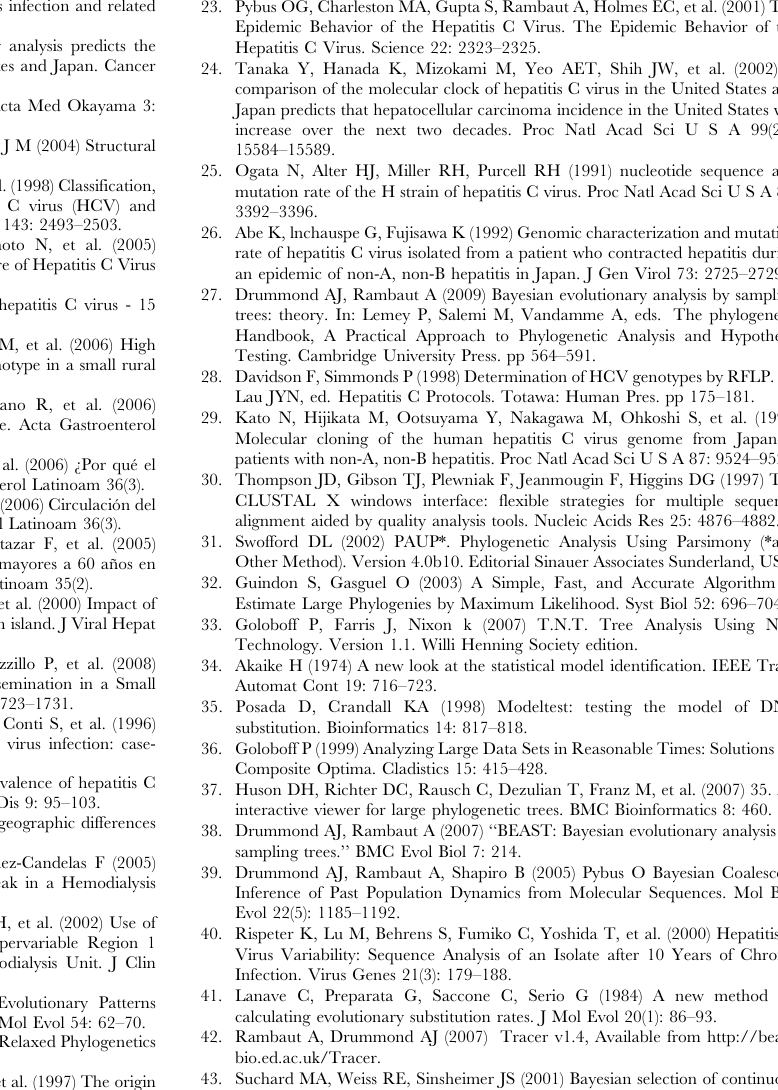
Figure S2 Parsimony phylogeny of the concatenated analysis obtained with the TNT software. The strict consensus tree of parsimony analysis obtained from eight most parsimony trees. A separation between sequences from the outbreak (red branches, n =55) and those from other sequences can be observed in the shaded area to the right of the figure in the strict consensus tree. Genotypes 1b (references sequences, n= 232) are represented by orange branches and the genotypes No-1b are represented by black branches (n= 34). Group of Wheelwright is detailed to the left of the figure with a bootstrap supports equal 63% from the same analysis. Figure S3 The marginal posterior density of substitutions rate for independent MCMC runs under different models. A) E1/E2